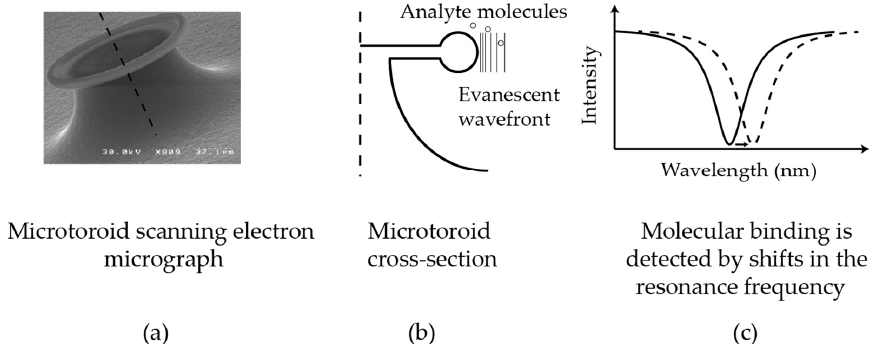
Figure 1. The microtoroid is an example of a whispering gallery mode optical resonator: ( a ) a scanning electron micrograph of a microtoroid; ( b ) a schematic of the evanescent wavefront interacting with molecules near the microtoroid (not to scale); and ( c ) molecules binding to the toroid’s surface changes the resonant frequency of the device. Whispering gallery mode resonators provide enhanced sensitivity as light interacts with the analyte molecules multiple times.